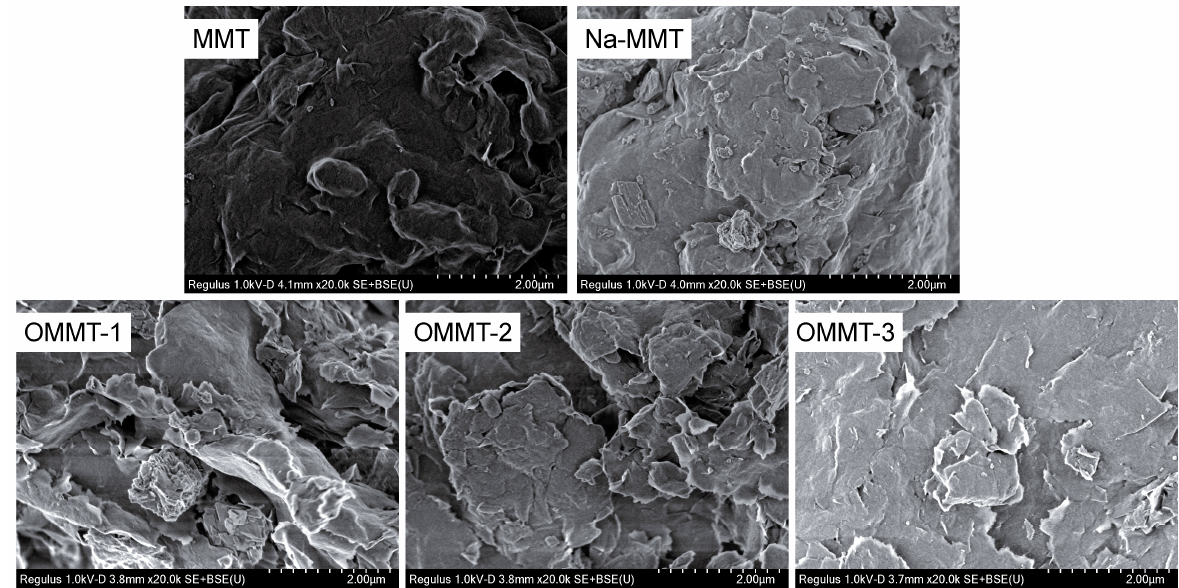
Figure 10. Scanning electron microscope (SEM) images of the montmorillonite (MMT), Na-MMT, OMMT-1, OMMT-2, and OMMT-3 samples.